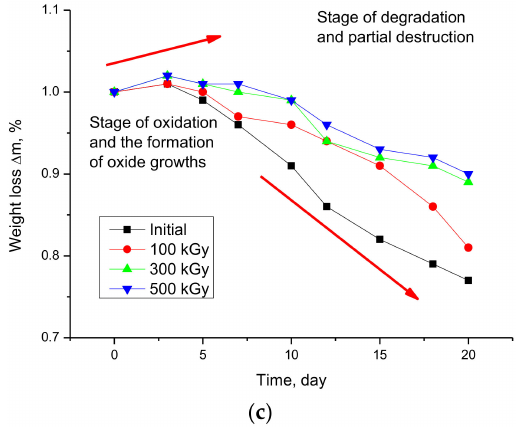
Figure 7. Dynamics of mass loss due to corrosion: ( a ) at a test temperature of 25 ◦ C; ( b ) at a test temperature of 36 ◦ C; ( c ) at a test temperature of 40 ◦ C.